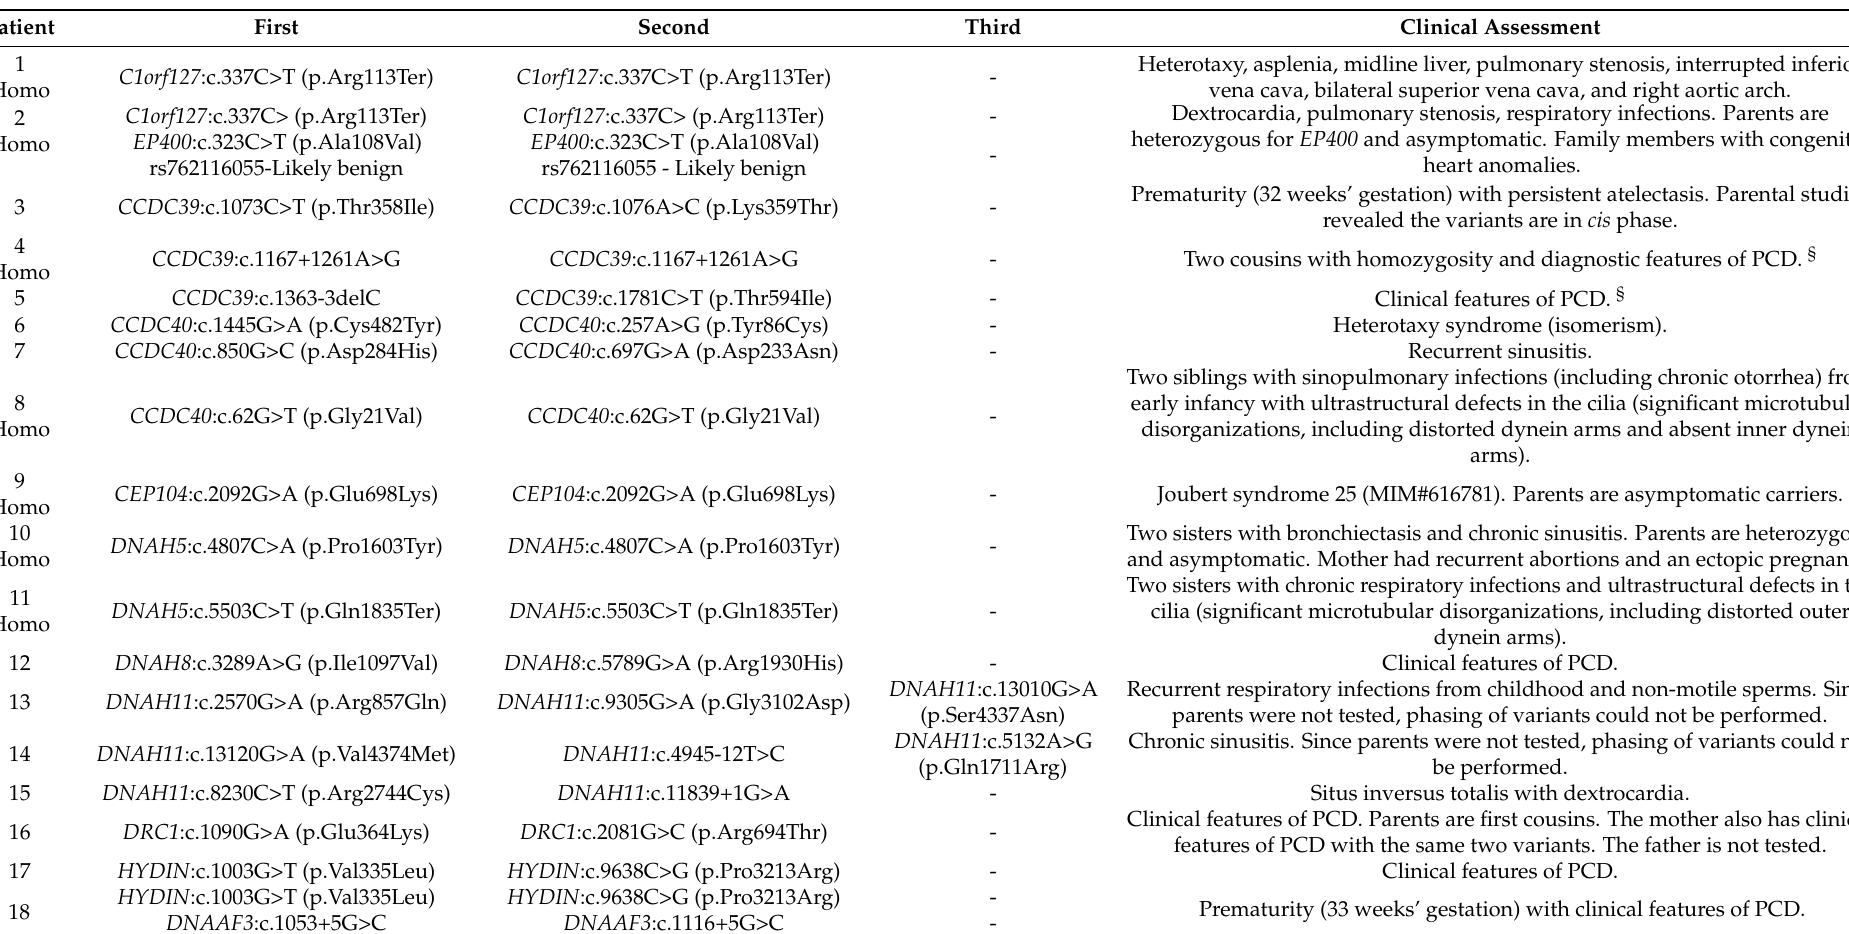
Table 3. Patients with double/triple heterozygous or homozygous variants. Predictions of pathogenicity of the variants are in Table 2. Heterozygous variants in these patients are not shown. XLR, X-linked recessive; Homo, homozygous. Novel variants are bolded. § This intronic change generates a cryptic donor splice site, which inserts an intronic sequence between exons 9 and 10 8 . The term ‘triple heterozygous’ signifies the presence of three variants in the same gene, as in Patients 13 and 14. As phasing was done, it is unclear on which allele the triple heterozygous variants resided, as pathogenic compound heterozygous variants could result in autosomal recessive